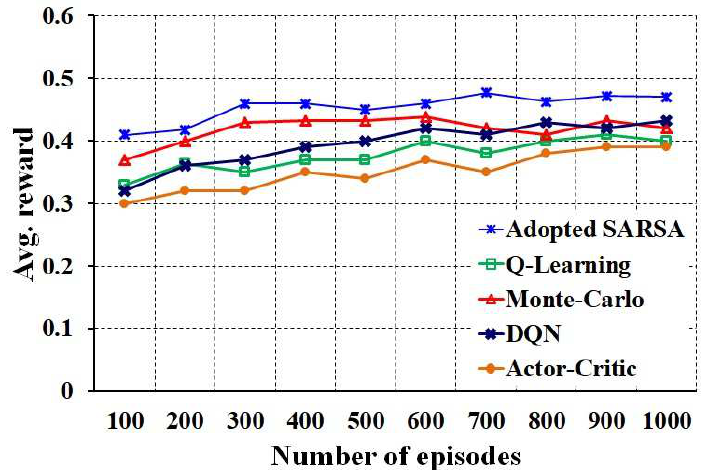
Figure 9. Average cumulative reward comparison.